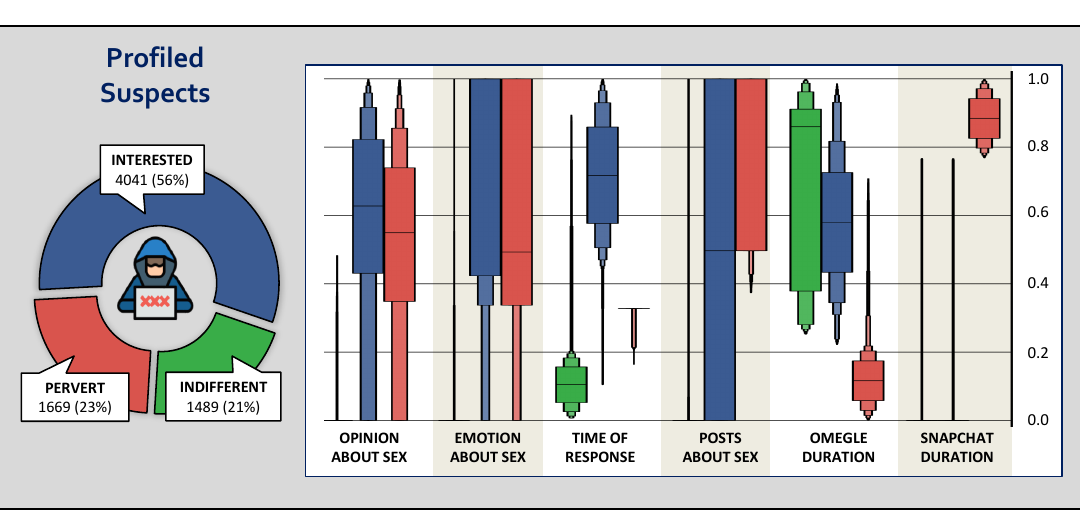
Figure 5. Comparative of the different types of profiled